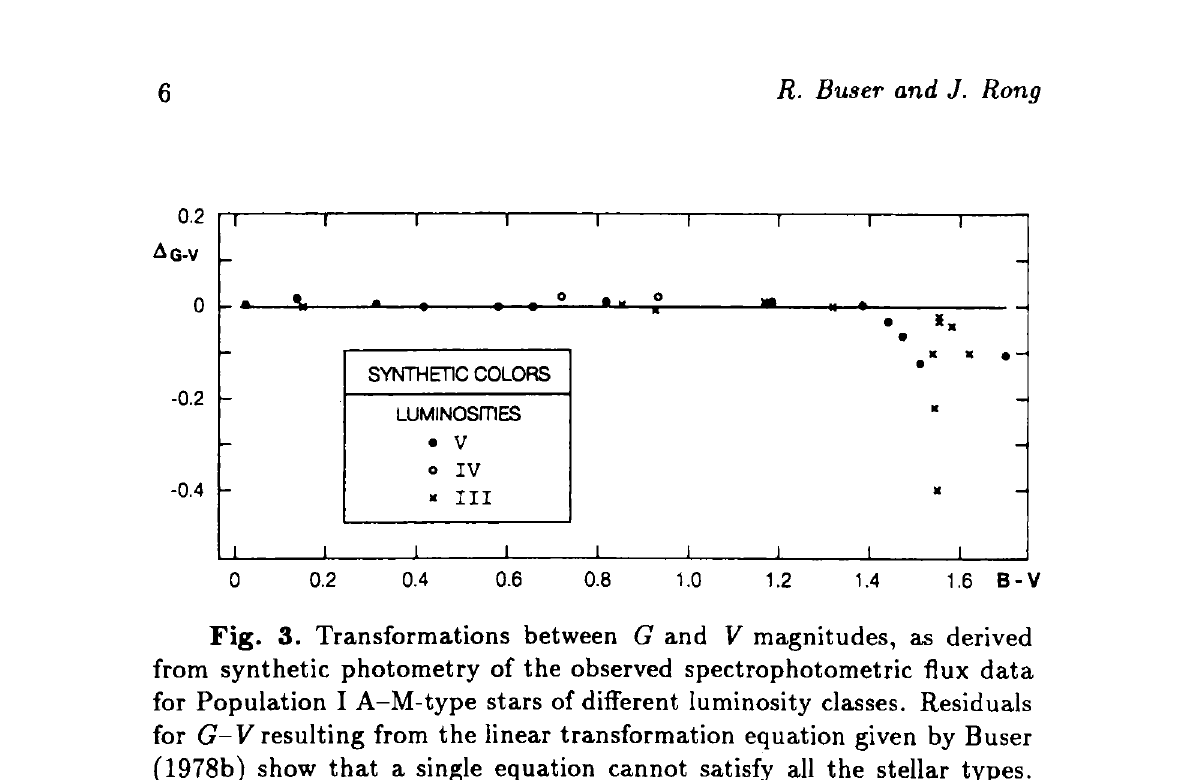
Fig. 3. Transformations between G and V magnitudes, as derived from synthetic photometry of the observed spectrophotometric flux data for Population I A-M-type stars of different luminosity classes. Residuals for G-V resulting from the linear transformation equation given by Buser (1978b) show that a single equation cannot satisfy all the stellar types. The M dwarfs and M giants at B-V > 1.4 follow transformations different from those for the bluer stars (Buser and Kaeser